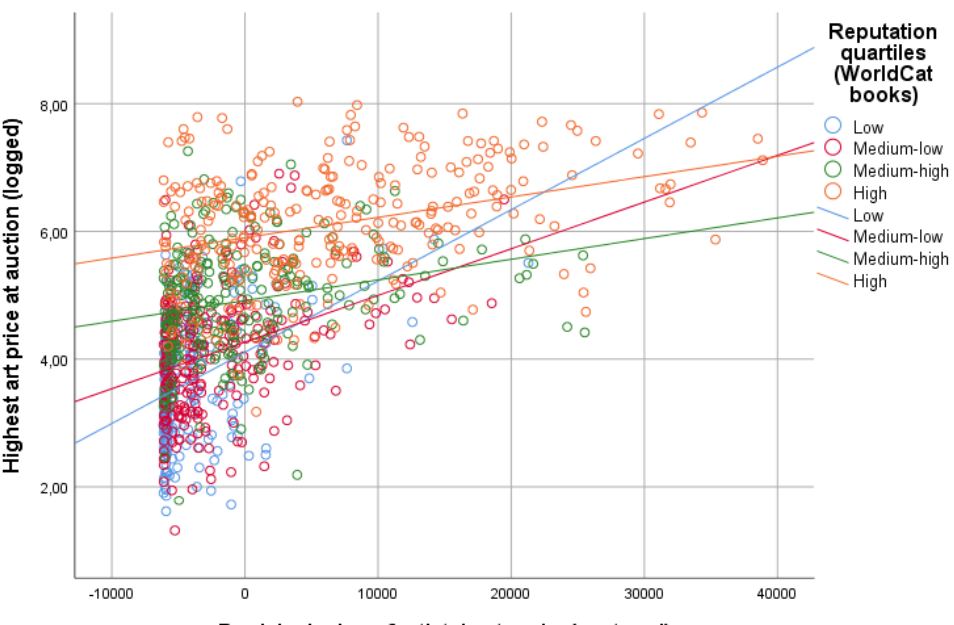
Figure 3. Scatterplot and regression lines of the effects of status (measured as network book inclusion) on auction prices (logged) for artists of differing levels of reputation.